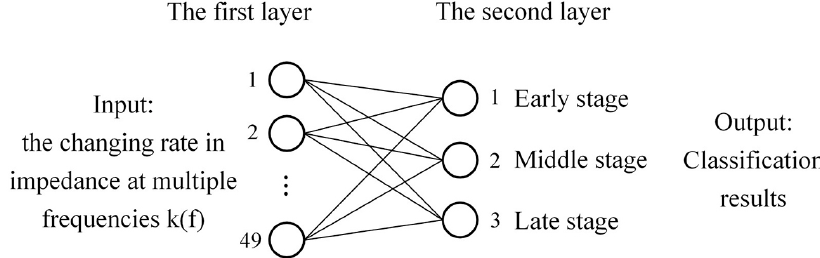
Figure 9. The topology structure of the self-organizing feature mapping network (SOM).